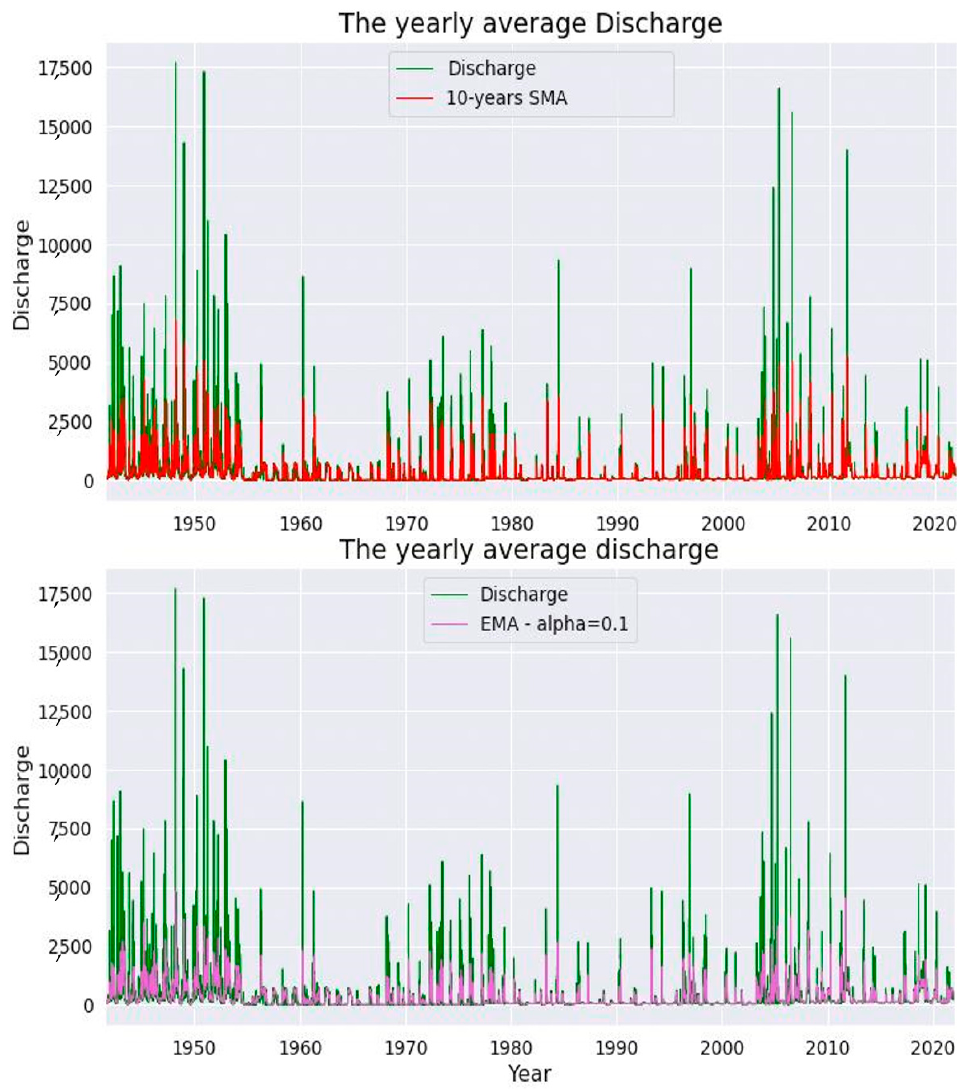
Figure 4. The yearly Moving Average (MA) with 10 years Simple Moving Average (MA) and Exponential Moving Average (EMA).